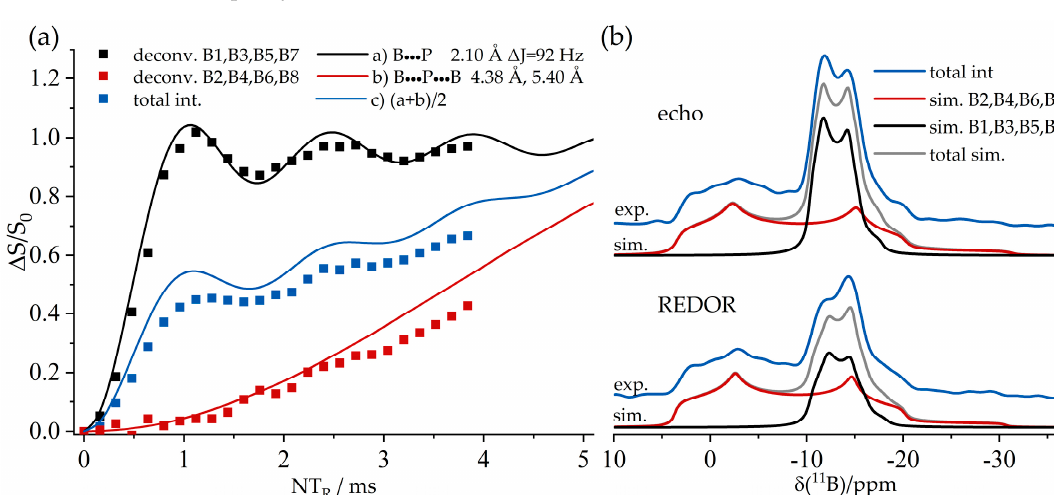
Figure 22. ( a ) Experimental 11 B{ 31 P} REDOR curves (squares) obtained for 5 . Data represented by the black and red squares were obtained by line-shape deconvolution of every 1D REDOR (S) and echo spectrum (S 0 ) (see Figure 11), using a single line for each of the two boron environments, i.e., for boron